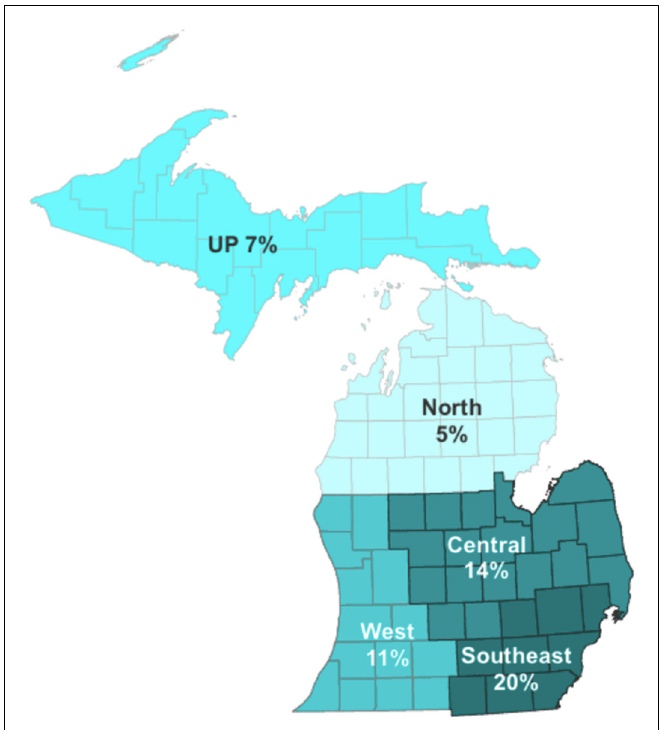
Figure 4. A Spatial Analysis of Good Food Stories in Michigan (UP=Upper